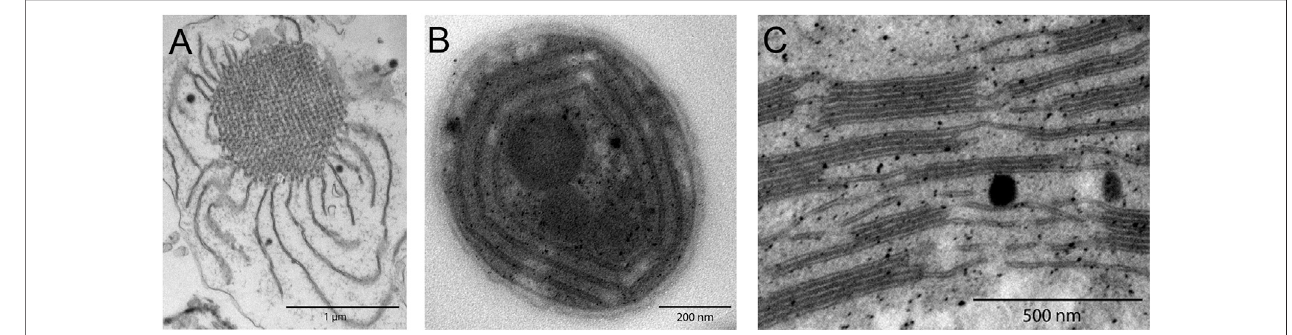
FIGURE 1 | TEM images of photosynthetic membrane systems, revealing complex structural characteristics. (A) Etiolated maize prolamellar body. (B) Concentric Synechocystis sp. PCC 6803 cyanobacterial thylakoids. (C) Higher plant grana stacks of Arabidopsis Col0, interconnected by stromal